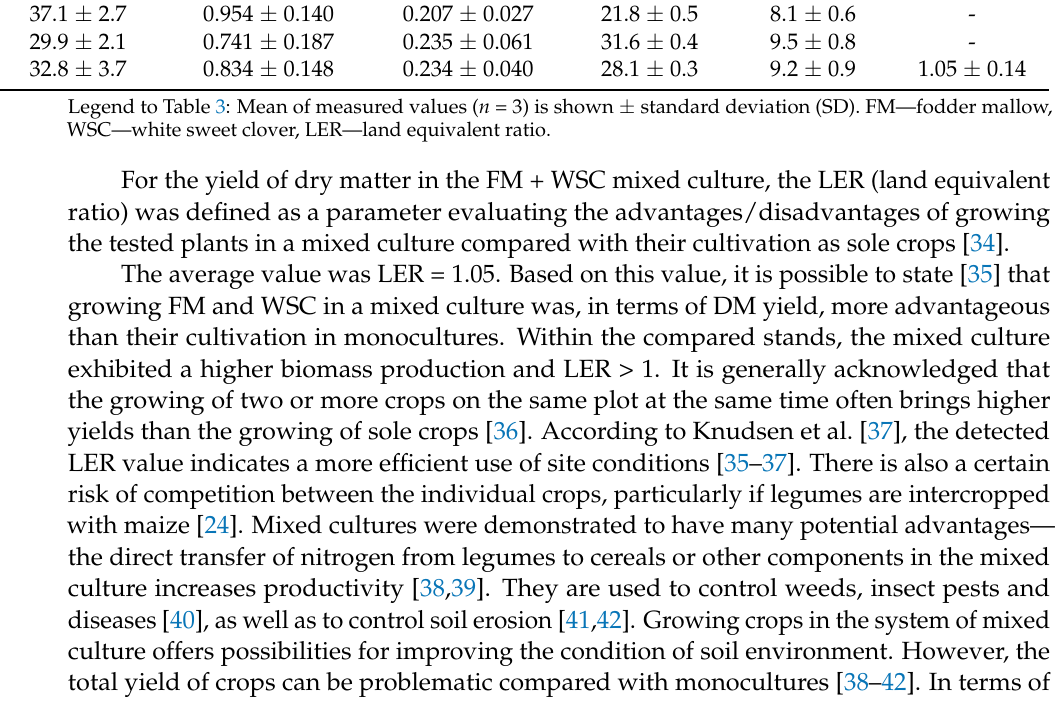
Legend to Table 3: Mean of measured values ( n = 3) is shown ± standard deviation (SD). FM—fodder mallow, WSC—white sweet clover, LER—land equivalent